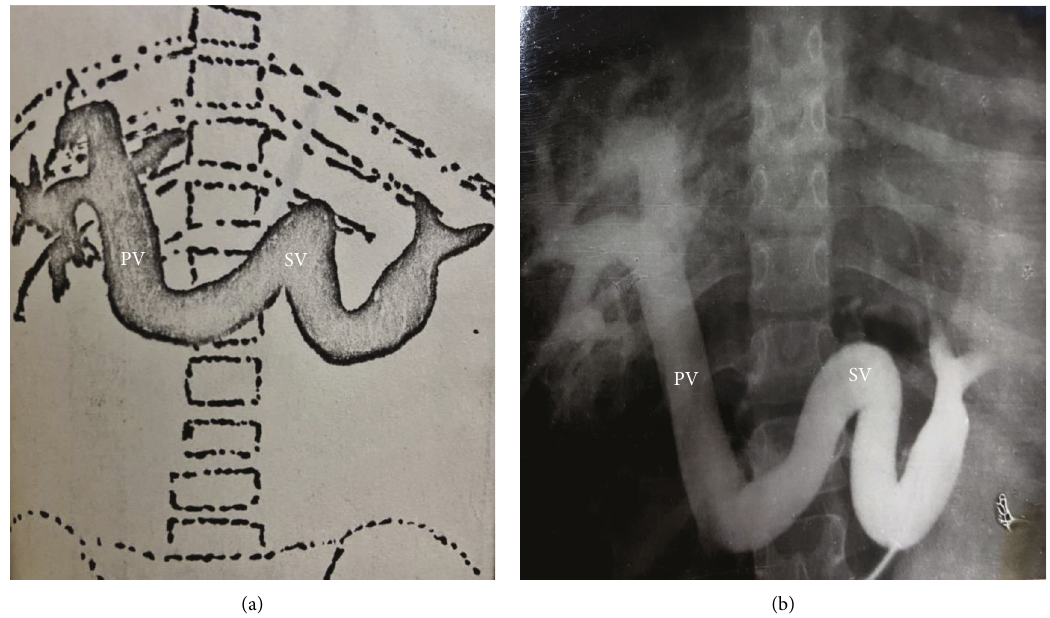
Figure 1: (a) and (b). Preoperative splenoportography (SPG) with the splenic vein (SV) angiomegaly in portal hypertension (PHT) with permeable portal trunk (PV—portal vein) and hepatogram of hepatic cirrhosis ( E. Br˘atucu —Private collection).